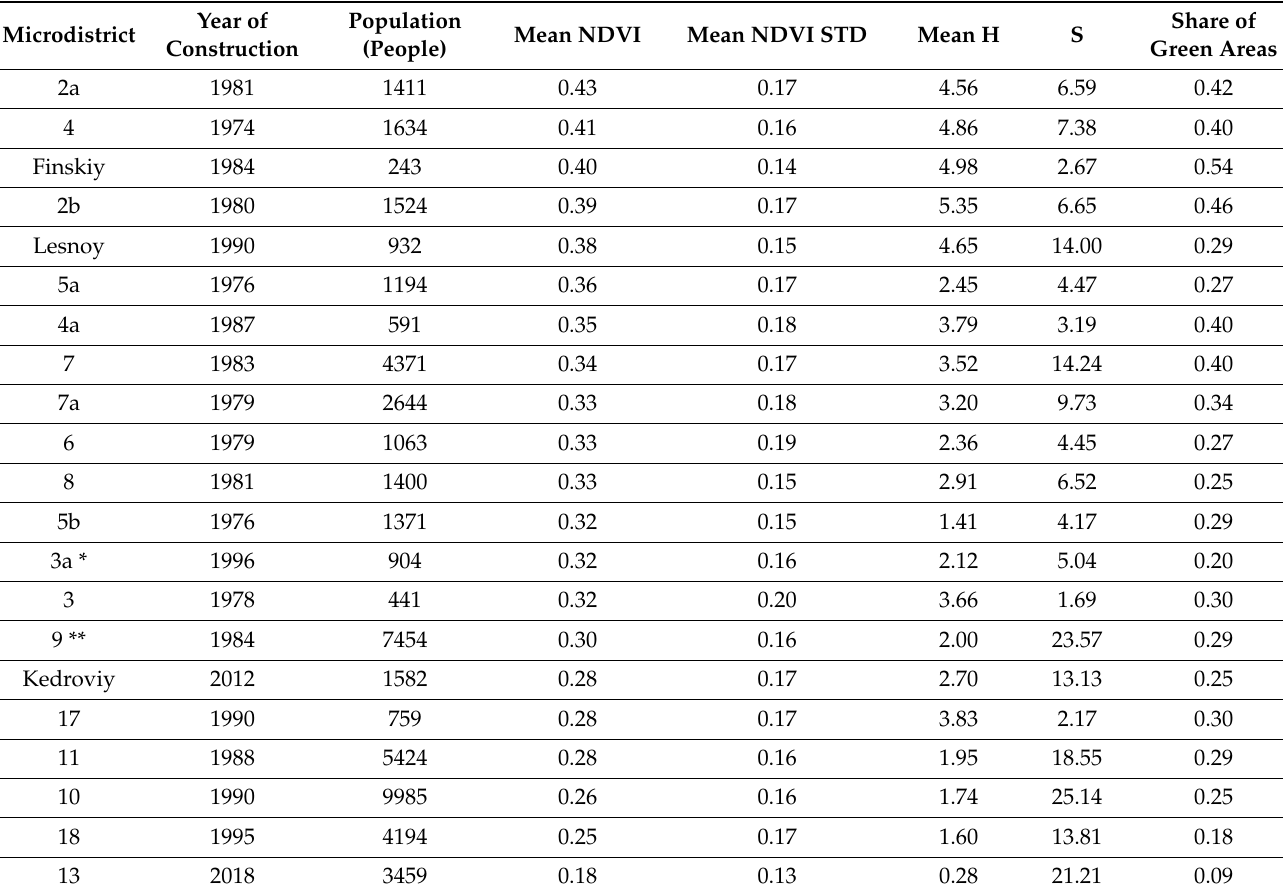
Figure 4. Comparison of vegetation characteristics of OGS ( a ) and microdistricts ( b ). Table 3. Characteristics of